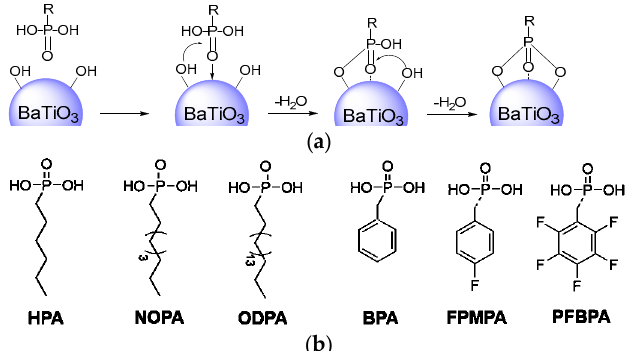
Figure 1. Mechanism of phosphonic acid binding to the surface of BT nanoparticles and the elec- trostatic potential maps of phosphonic acid modifiers obtained from DFT modeling. The red color indicates negative charge, whereas the blue color indicates positive charge. ( a ) Binding mechanism between phosphonic acid and BT. ( b ) Electrostatic potential maps of phosphonic acids.